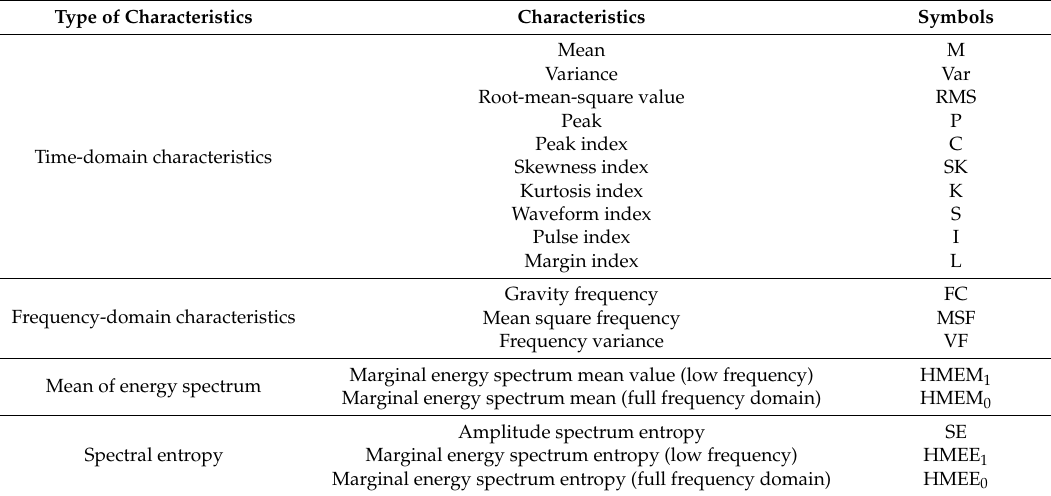
Table A1. Symbols of